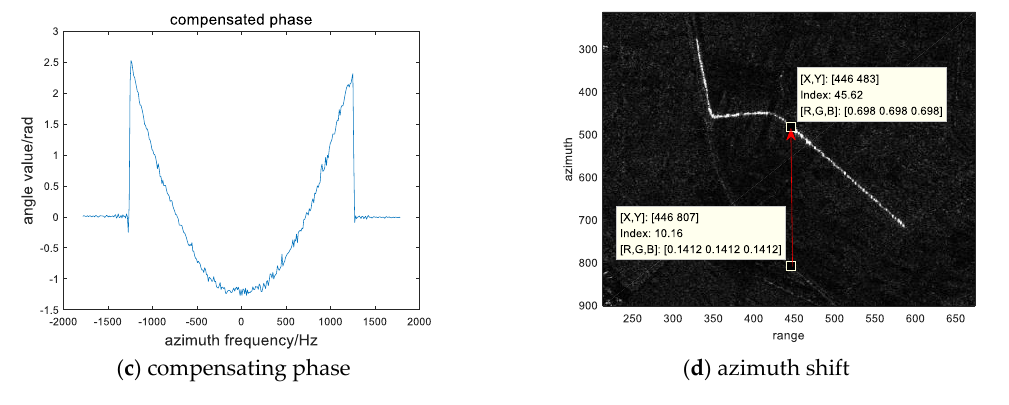
Figure 7. Processing of the moving train data